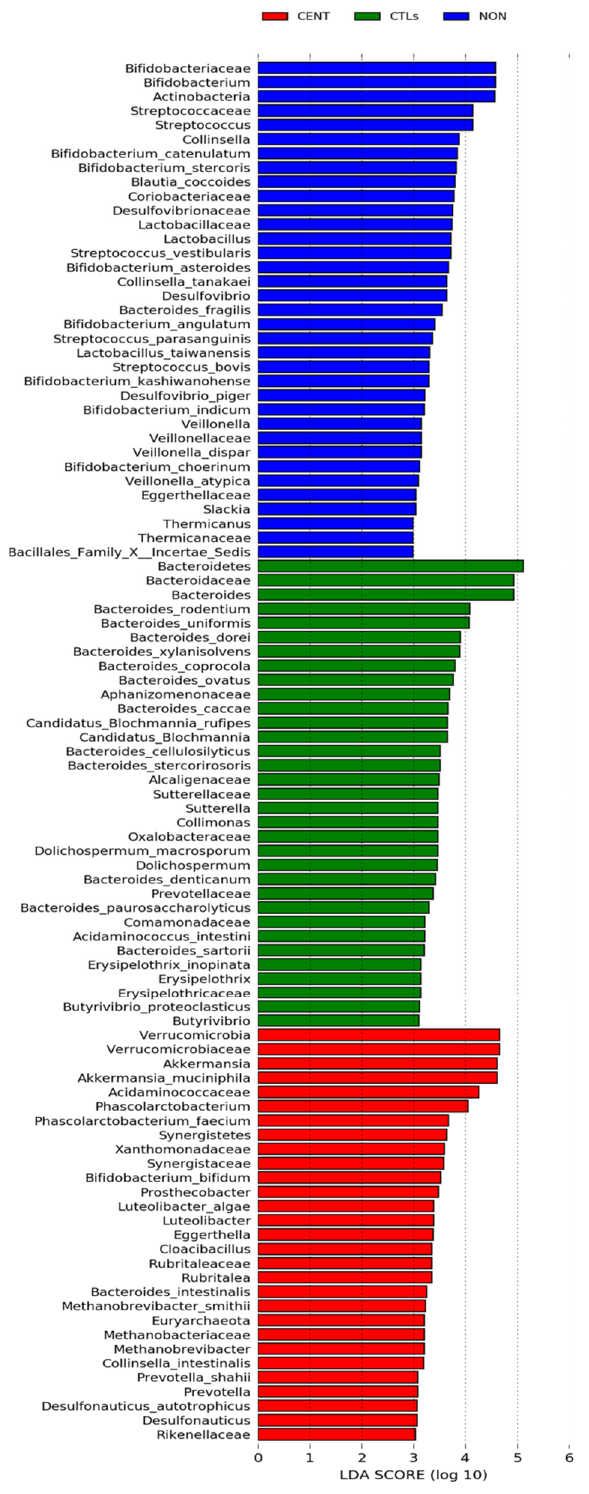
Figure 2. Linear Discriminant Analysis Effect Size (LEfSe) of microbial taxa between CENT, NON and CTLs.